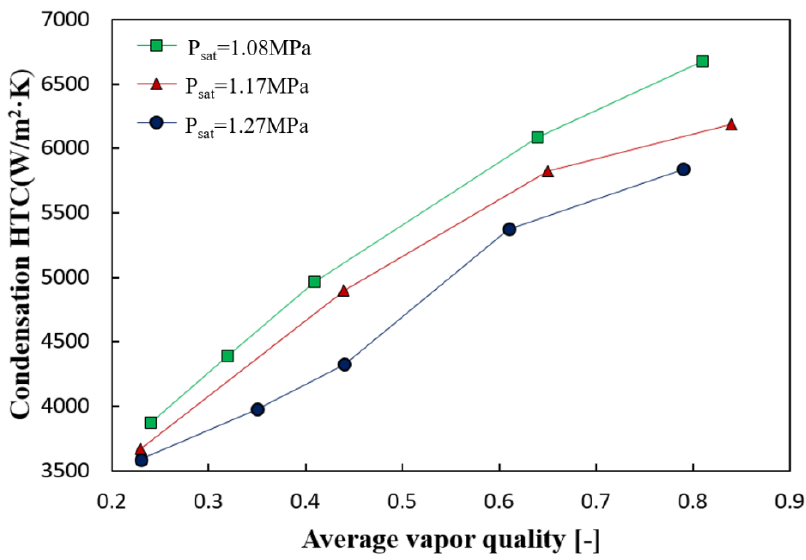
Figure 10. Condensation HTC according to saturation pressure at various vapor quality condition.